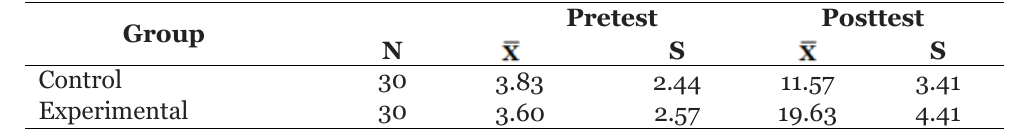
Learning Environments Mean and Standard Deviation Values